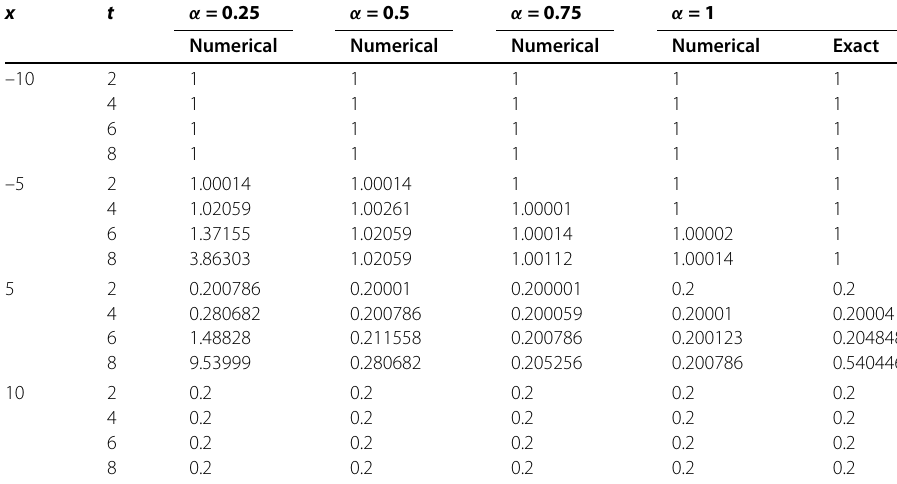
Table 2 The results obtained by the FRDTM for different values of α for Example 4.1